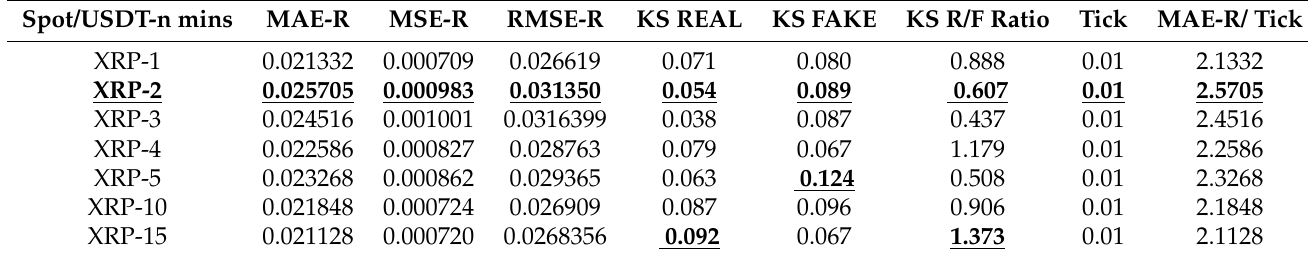
Table 14. We examined XRPUSDT spot prices against generated prices at one, two, three, four, five, ten and fifteen minute intervals. For KS R/F Ratio, two out of seven are more significant than one, where the highest KS REAL and FAKE are 0.092 and